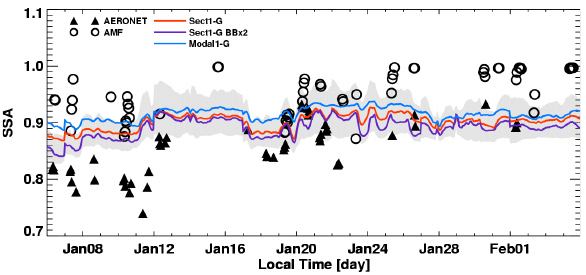
Figure 10 Hourly SSA at 600 nm during the simulation period from the AERONET and AMF retrievals and the WRF-Chem simulations in different cases in the vicinity of Niamey. The gray area represents the variation of Sect1-G simulated SSA due to the uncertainty of n i (imaginary part of refractive index) of mineral dust.